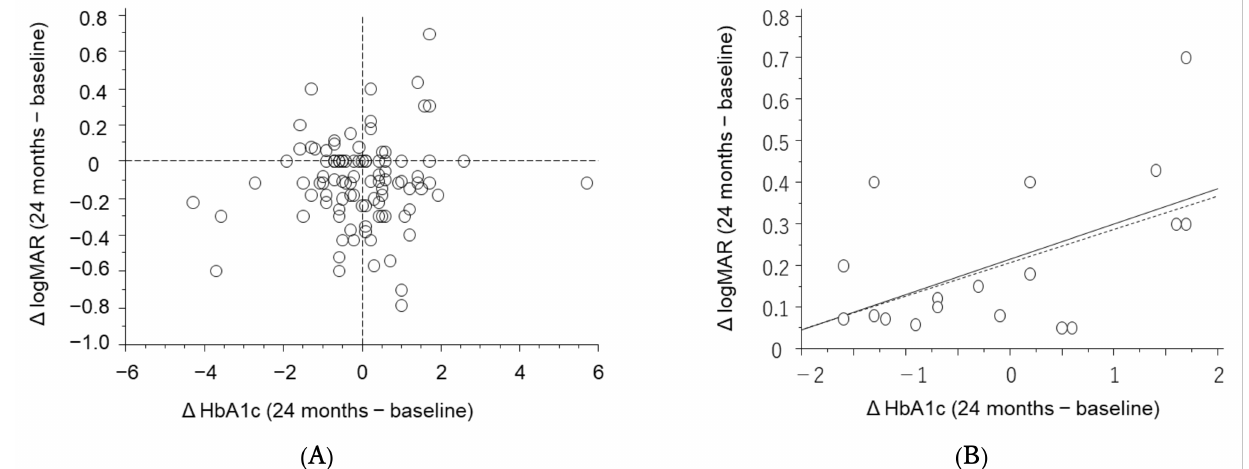
Figure 3. Linear correlation between changes in best-corrected visual acuity (BCVA) [logarithm of the minimal angle of resolution (logMAR)] and hemoglobin A1c (HbA1c) over the two-year period. ( A ) No significant correlation was found in all patients. ( B ) In patients with worsening BCVA, significant correlations were found ( p = 0.0155, R 2 = 0.299). Solid line: simple regression analysis. Broken line: robust regression analysis. The vertical dotted line indicates no change compared with baseline in HbA1c and BCVA values. Proximity to the lower-left corner implies improvement of BCVA and a decrease in HbA1c levels over the